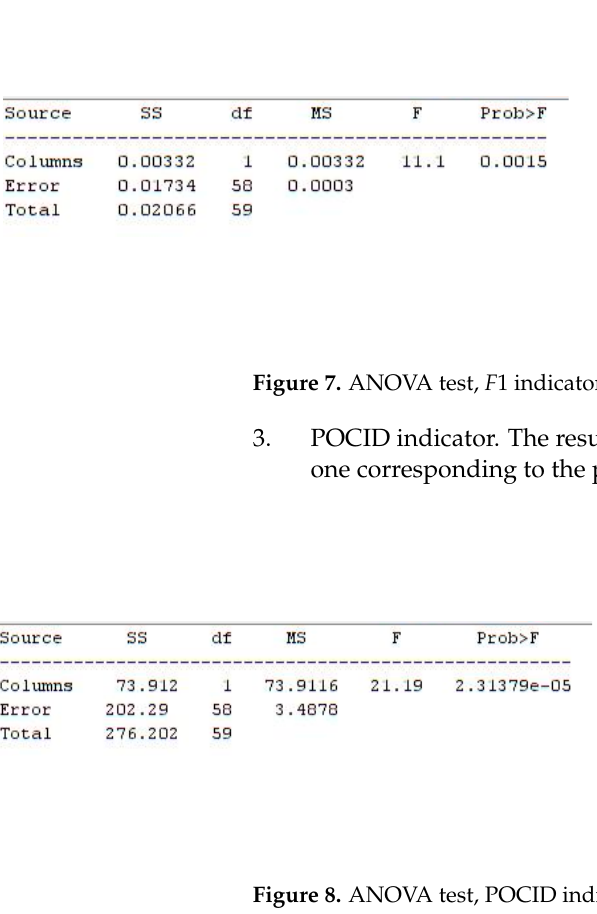
Figure 8. ANOVA test, POCID indicator.